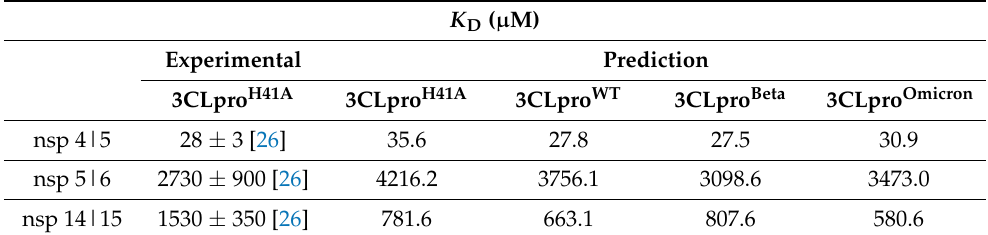
Table 2. Relationship between the affinity rates obtained experimentally with the rates obtained by pre- diction. Prediction rates were described using a regression model ln K D = ( 31.5 ∗ ∆ G − 122124.0 ) / RT and compared with experimental K D data from Zhao and co-authors